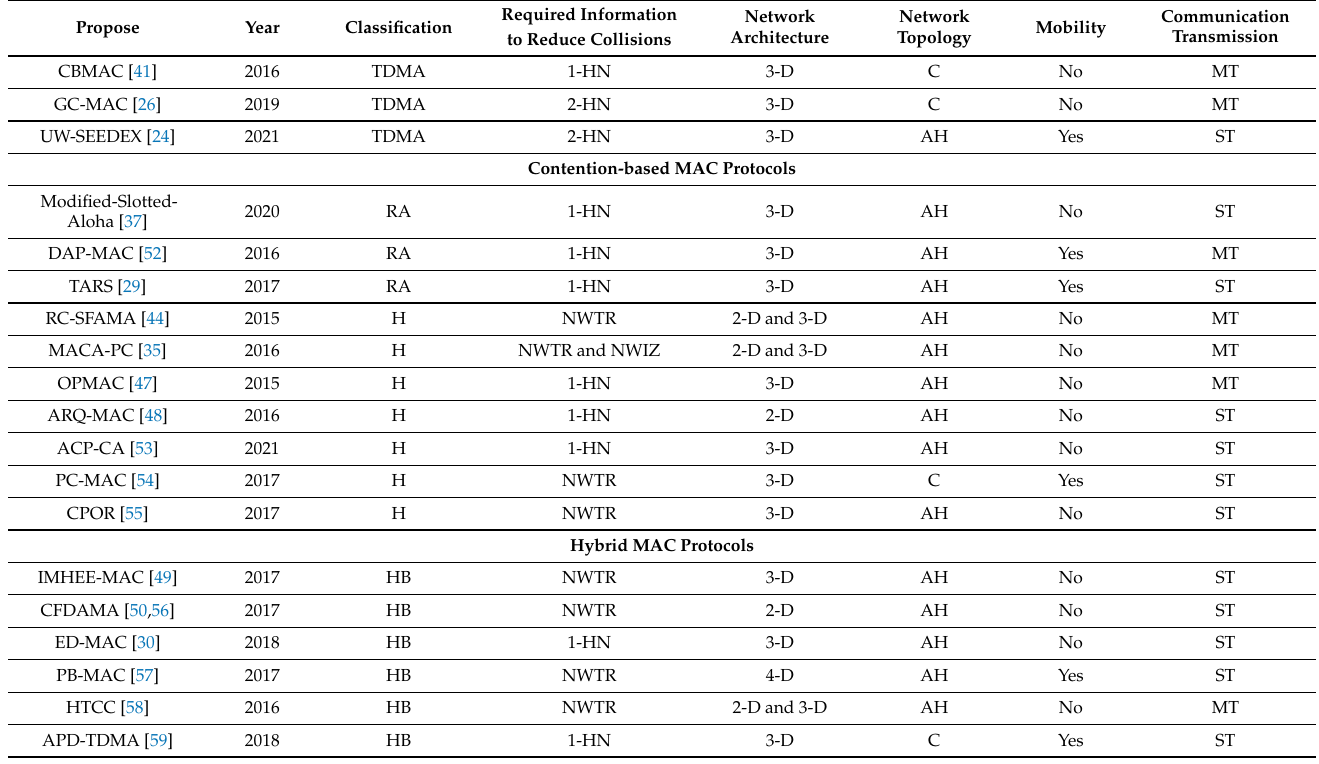
Table 2. Summary of the Design Characteristics of UWSN MAC